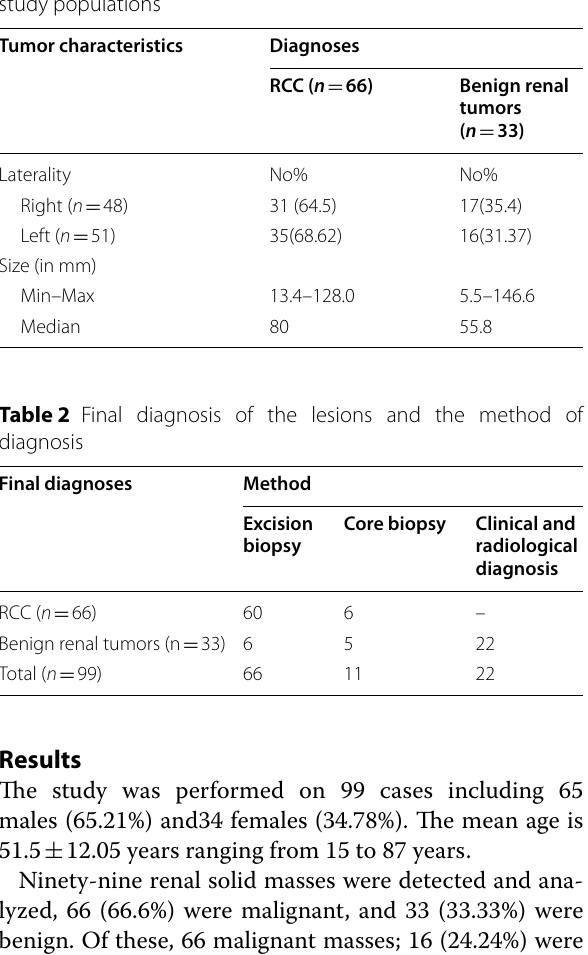
Table 3 Post contrast CT parameters (attenuation value) among solid renal lesion ( n